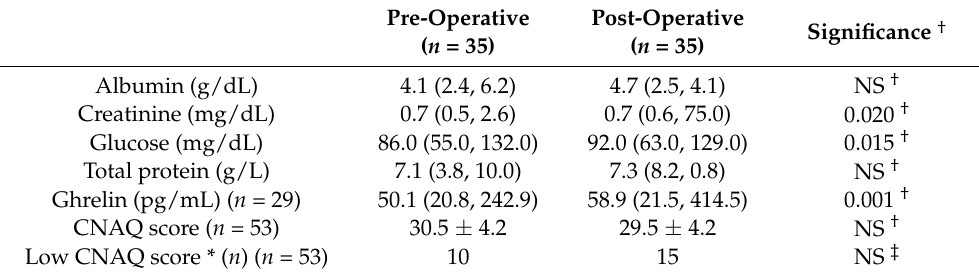
Table 3. Post-operative changes in appetite and serum biochemical markers ( n = 35).